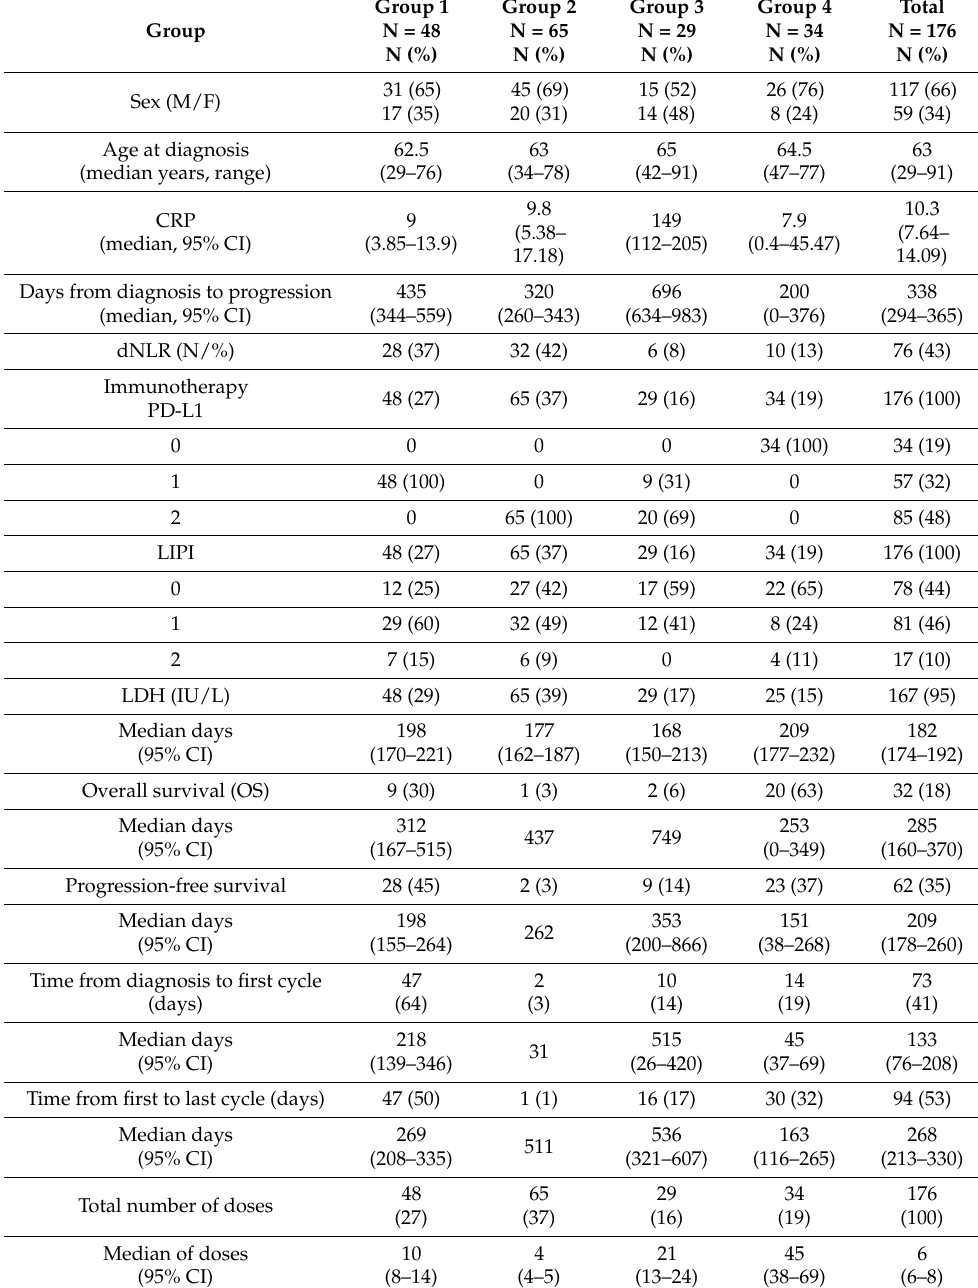
Table 1. Demographic, anamnestic, and clinical characteristics of patients included in the study (expressed as frequencies and median values, 95%